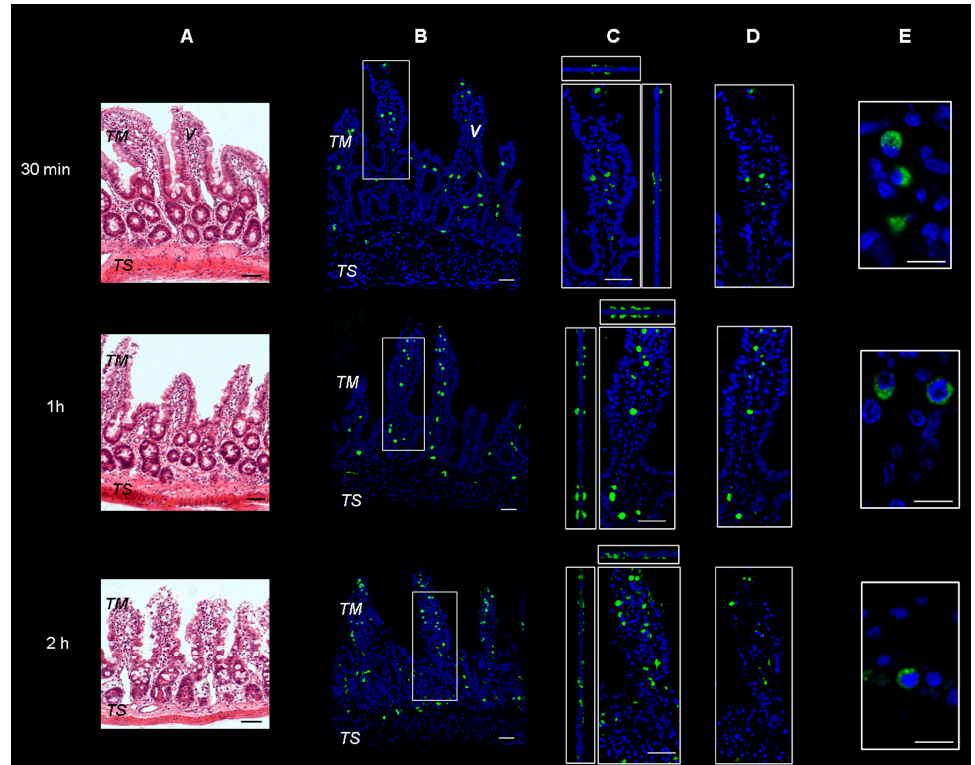
Figure 1. Representative images of rat gut sections after 0.5 h, 1 h and 2 h incubation in Ussing chamber. TM: tunica mucosa; TS: tunica serosa; V: intestinal villus. ( A ) Hematoxylin and eosin stain. Scale bars 50 µ m. ( B – E ) Immunofluorescence confocal microscopy; individual fluorescent channels: green (SRM, Sucrosomial ® Raw Material Iron) and blue (nuclei). ( B ) Bidimensional image of the maximum intensity projection. Scale bar 50 µ m. ( C ) Blow-up of the squares shows higher magnification of the three-dimensional pictures with the respective orthogonal projections. Scale bar 50 µ m. ( D ) Images acquired in one Z-plane (31st of 48, 46th of 75, and 33rd of 65, incubated for 0.5, 1 and 2 h respectively). Scale bar 50 µ m. ( E ) Images acquired in one Z-plane (28th of 40, 15th of 46, 28th of 47, incubated for 0.5, 1 and 2 h, respectively) at a magnification of different sections higher than that of ( B – D ). Scale bar 10 µ m.